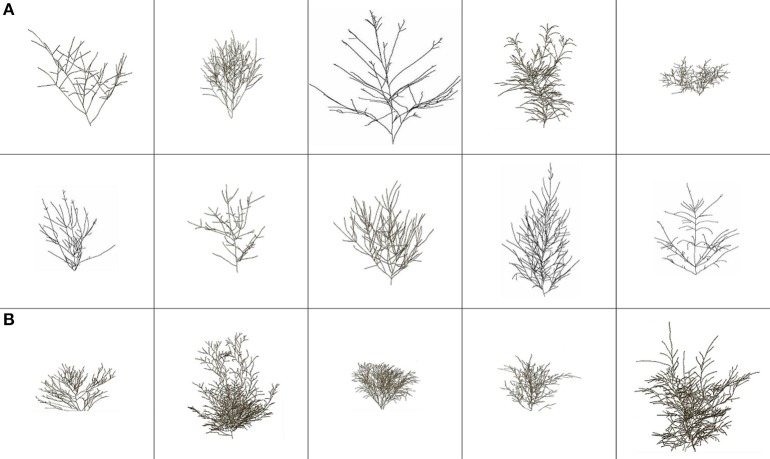
Skeletal branching patterns (i.e., branches are represented with a one-voxel thickness) for the 15 miniature conifers (A) with needlelike leaves (first two rows) and (B) with scalelike leaves (third row), following the order of Table 2 from left to right instead of top-bottom; for example, the top left panel shows Abies balsamea Nana (Dwarf Balsam Fir), while the top right one shows Juniperus horizontalis Blue Pygmy (Creeping Juniper). Width and height (cm) values (for complete crowns; see Figure 5) range from 10.3, 7.9 (Chamaecyparis pisifera Golden Pin Cushion, Sawara Falsecypress) to 27.5, 22.2 (Cryptomeria japonica Gyokuryu, Japanese Cedar), respectively. These 3-D renderings and those of Figure 5 were constructed from CT scanning data, and conserve the relative differences in size (width and height) among the 15 coniferous trees.